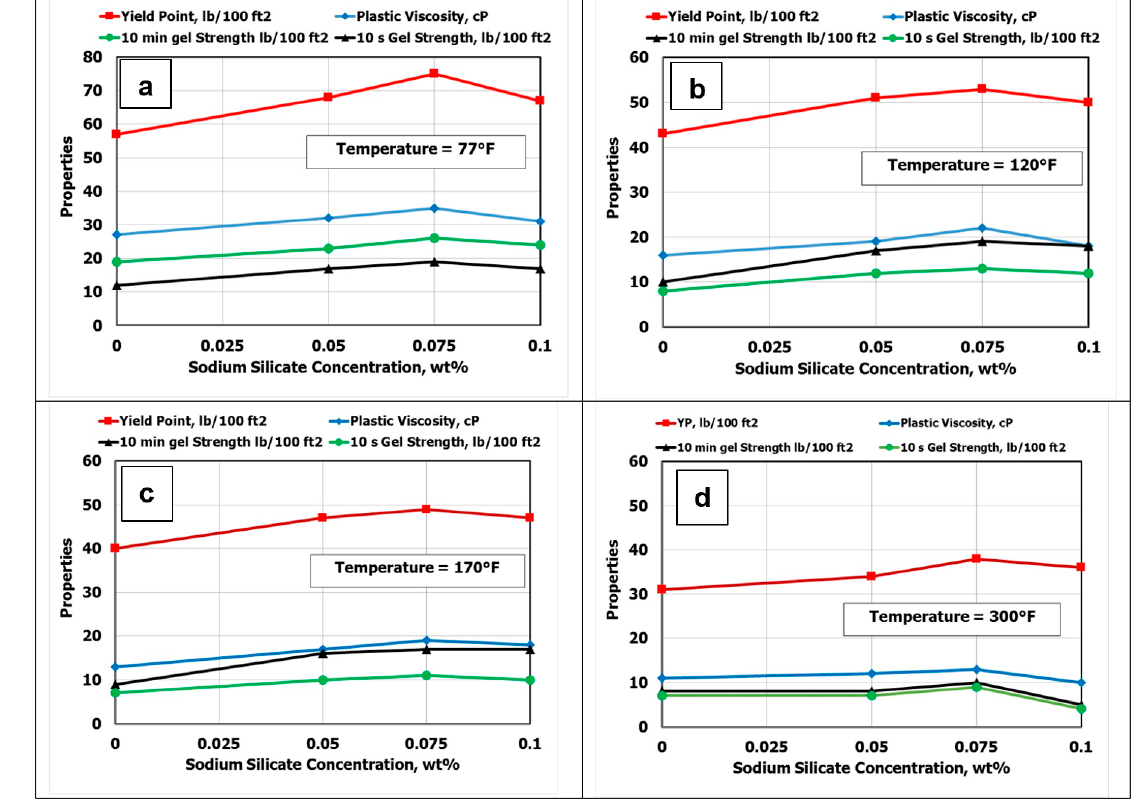
Figure 2. Effect of temperature on the rheological properties of water-based drilling fluid at a different concentration of SS. ( a ) At 77 °F ( b ) at 120 °F ( c ) at 170 °F ( d ) at 300 °F